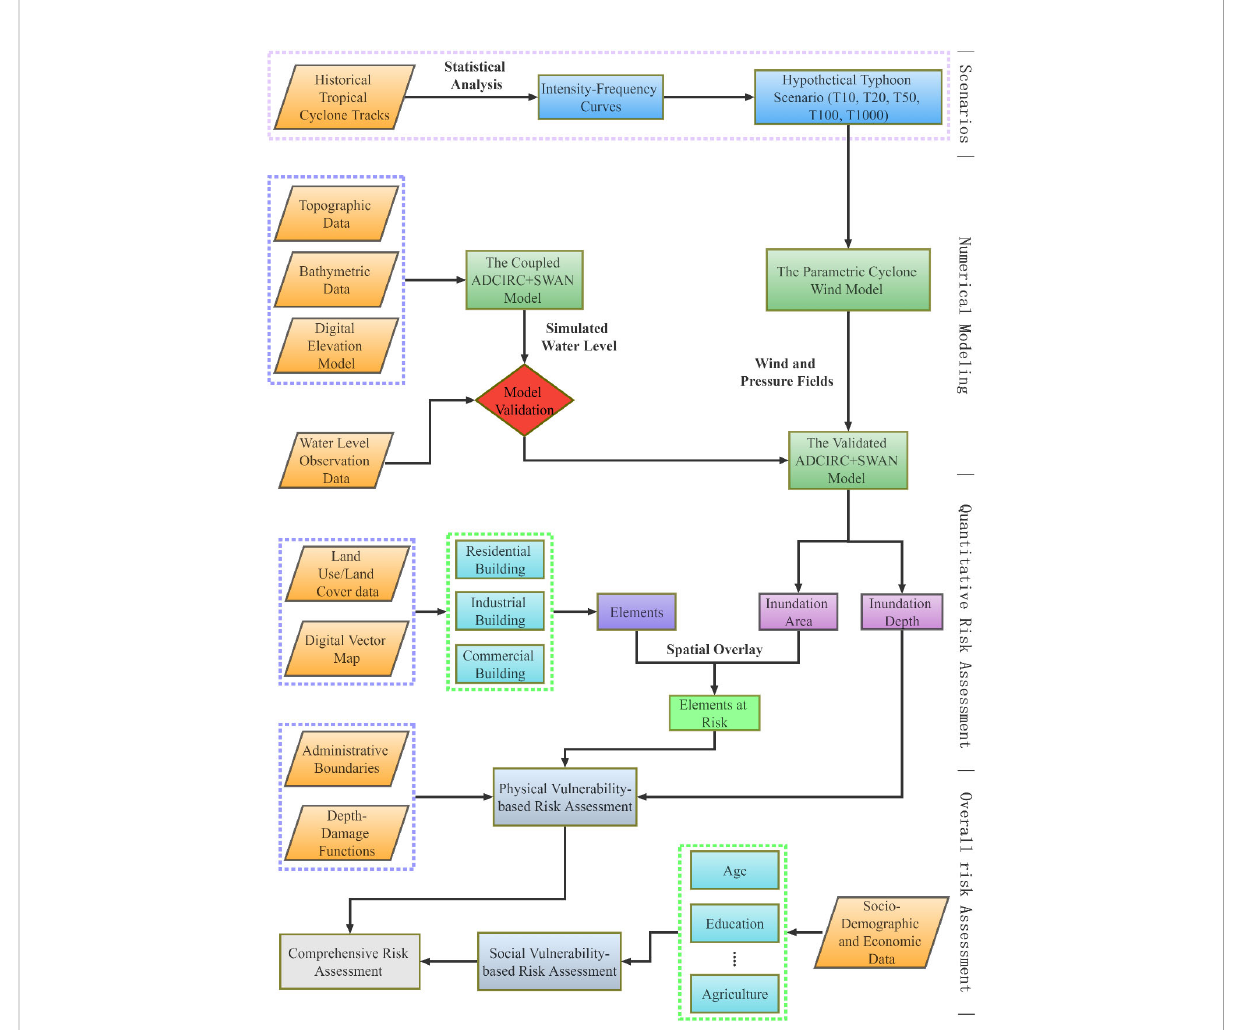
FIGURE 2 Flowchart of the proposed method for conducting the comprehensive risk